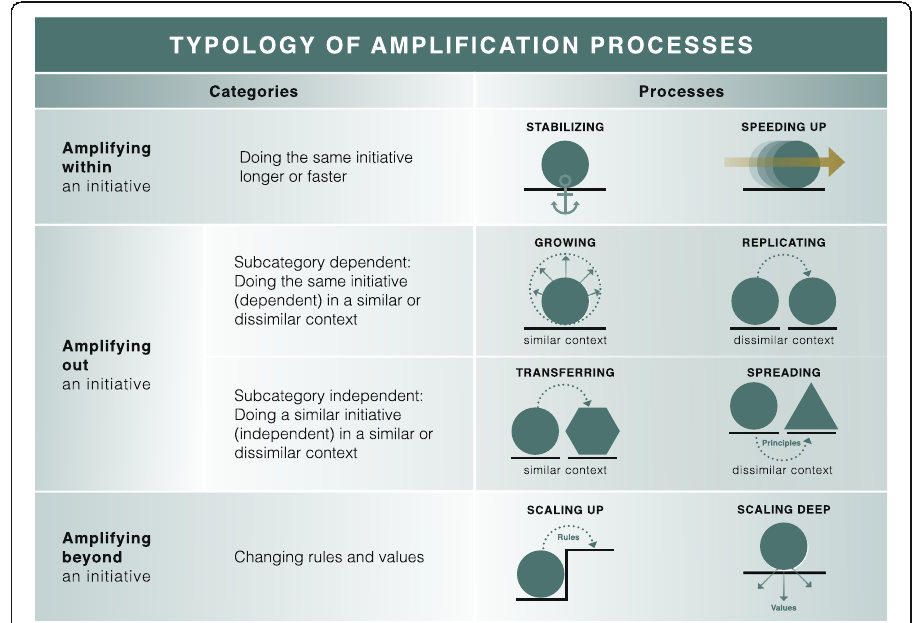
vertical correspondence between the eight illustrations